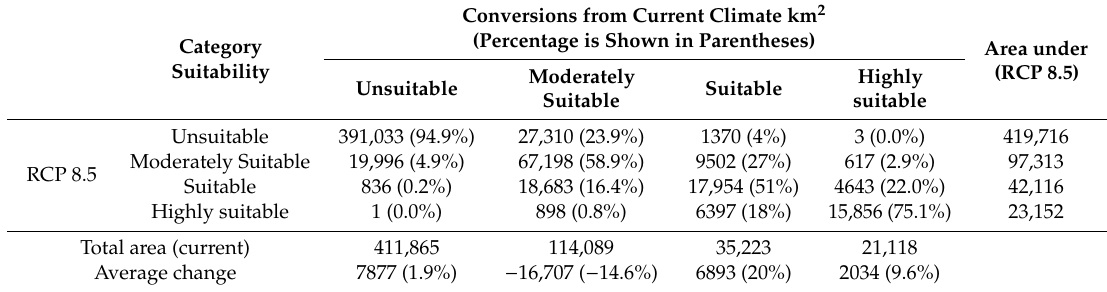
Table 4. Changes in land suitability for maize production under RCP 8.5 in Kenya for 2070 compared to current suitability.